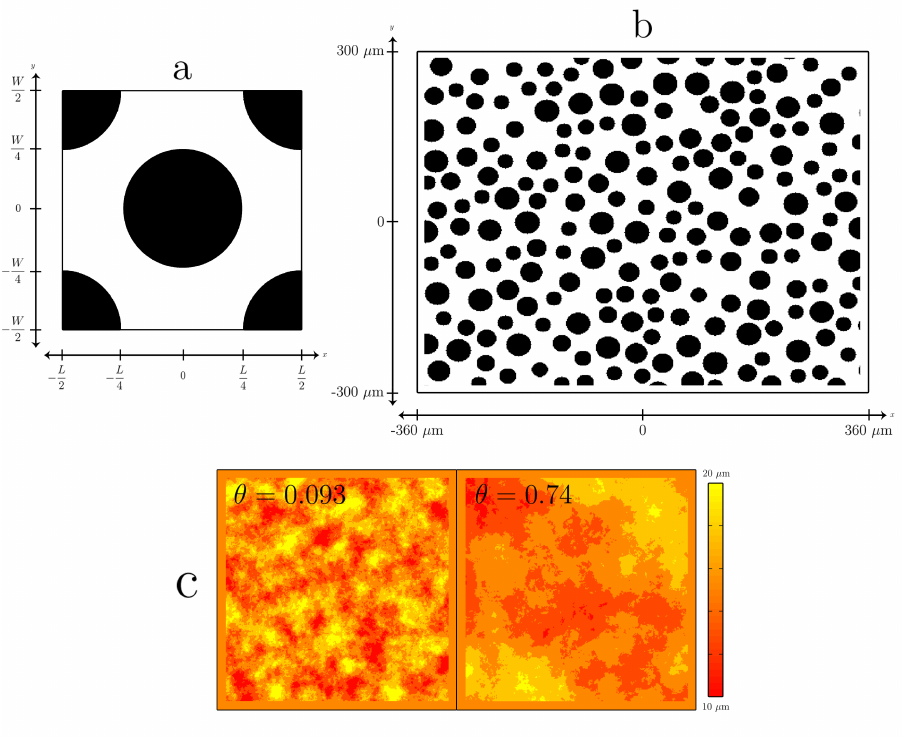
Figure 2. Flow is driven from left to right in all test cases. Cylindrical pillars span the entire depth (into the page), resulting in zero aperture. ( a ) Top-down view of unit cell with length ( L ) and width ( W ) of 335 µ m. Cell aperture may be uniformly 20 µ m, or vary between 10 and 20 µ m. Cylindrical pillars have radius L/ 4 ; ( b ) Top-down view of a heterogeneous pore geometry, with dimensions of 720 × 600 × 20 µ m and cylindrical pillars of varying size; ( c ) Two realizations of randomly-generated aperture fields used in unit cell simulations, one each for the smallest (0.093) and largest (0.74) values of θ . Aperture varies between 10 and 20 µ m. Cylindrical pillars not